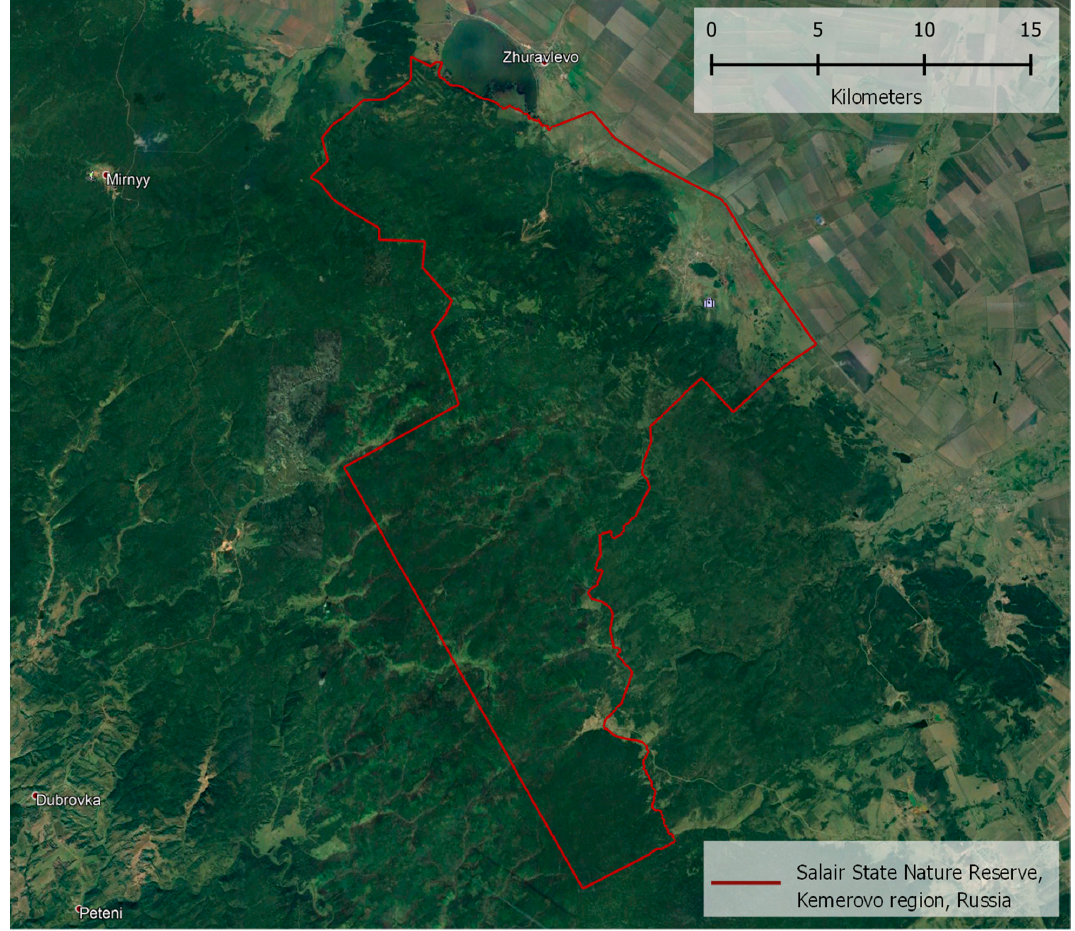
Figure 1. The red contour is the territory of the Salair State Nature Reserve, Kemerovo region, Russia, Asia. Table 4. Data on UAV